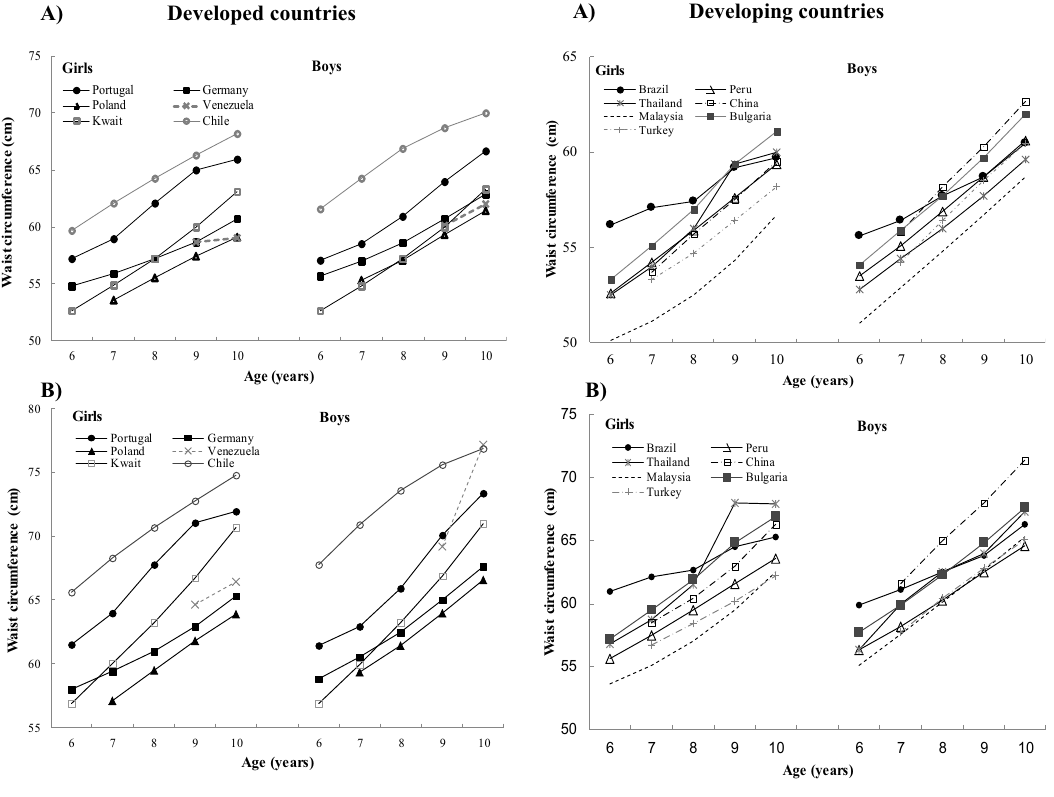
Figure 2: Comparisons of age and sex in the 50th percentile (A) and 75th percentile (B) values of waist circumference between Portugal and other developed countries and Brazil and other developing